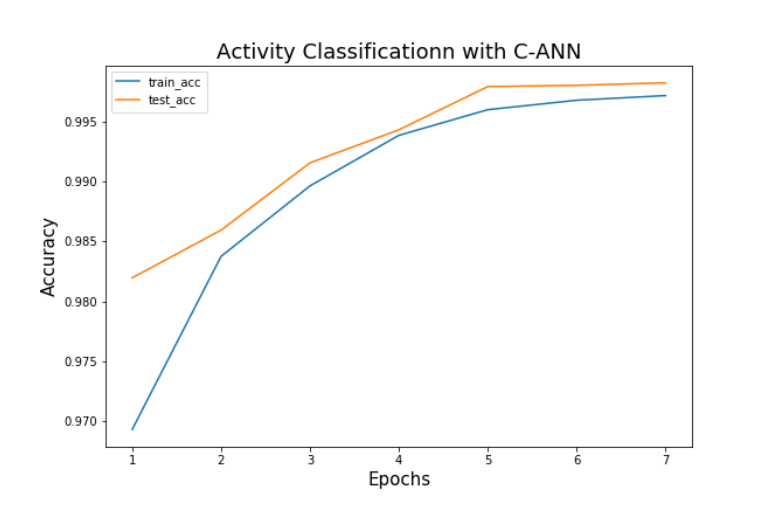
Figure 16. Training and testing accuracy of C-ANN